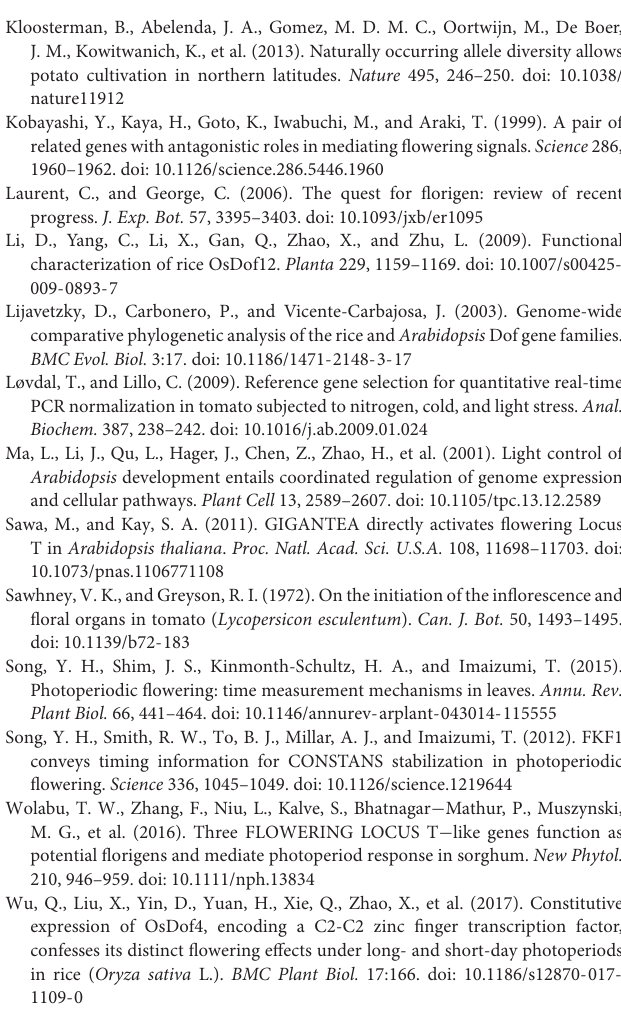
Supplementary Figure 1 | Phylogenetic analysis of Arabidopsis and tomato DOF protein families. The Arabidopsis and tomato gene trees were inferred by the neighbor-joining method after alignment of the DOF domains of the 36 Arabidopsis and 34 tomato DOF proteins. The resulting Major Clusters of Orthologous Genes (MCOG) A, B, C, and D are indicated. White circles with tables represent Arabidopsis CDF proteins, and black circles represent tomato CDF proteins. The numbers nearby tree branches indicate their confidence. The scale bar represents 0.05 estimated amino acid substitutions per site.